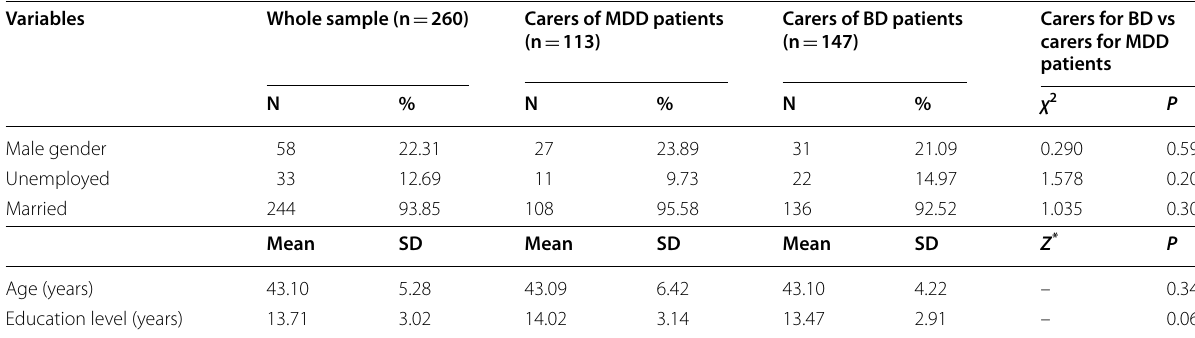
Table 2 Demographic information of participants’ carers